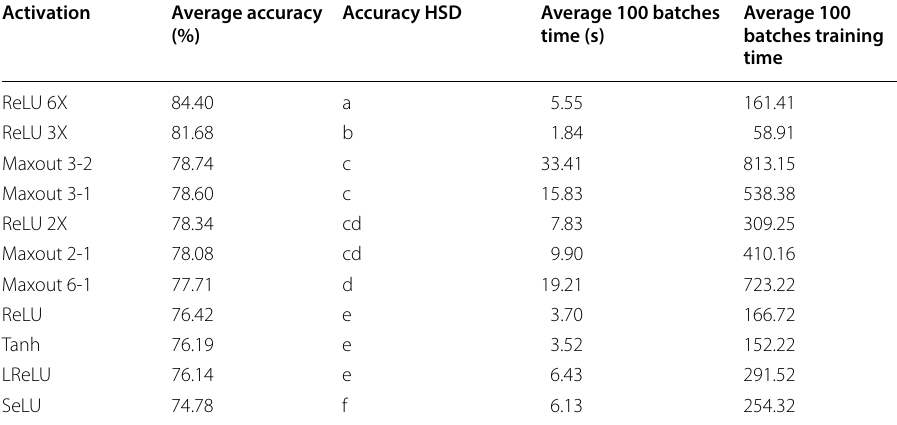
Table 14 Activation HSD test on all datasets